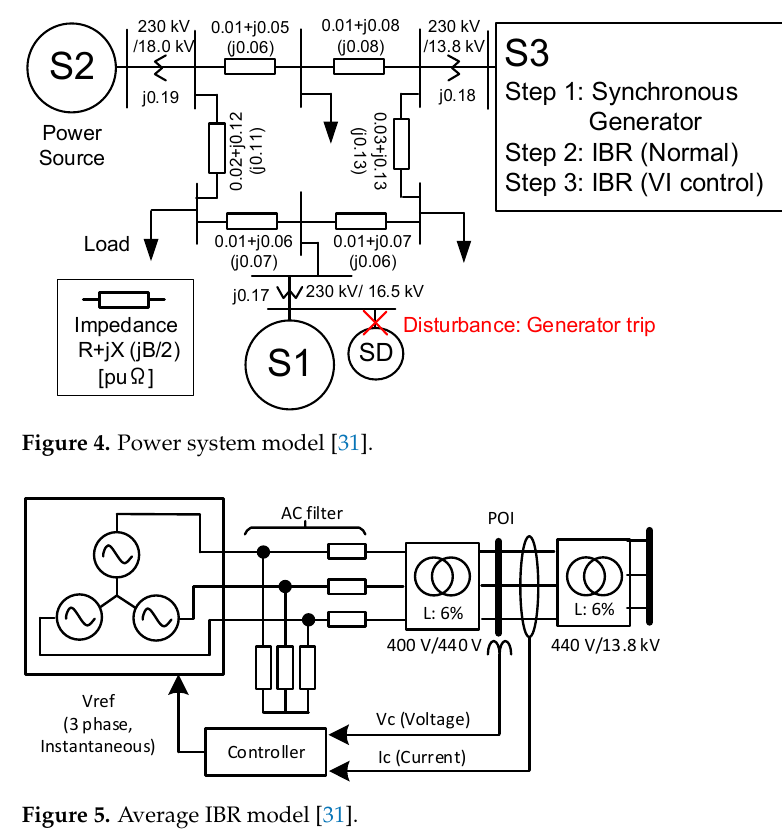
Figure 5. Average IBR model [31].